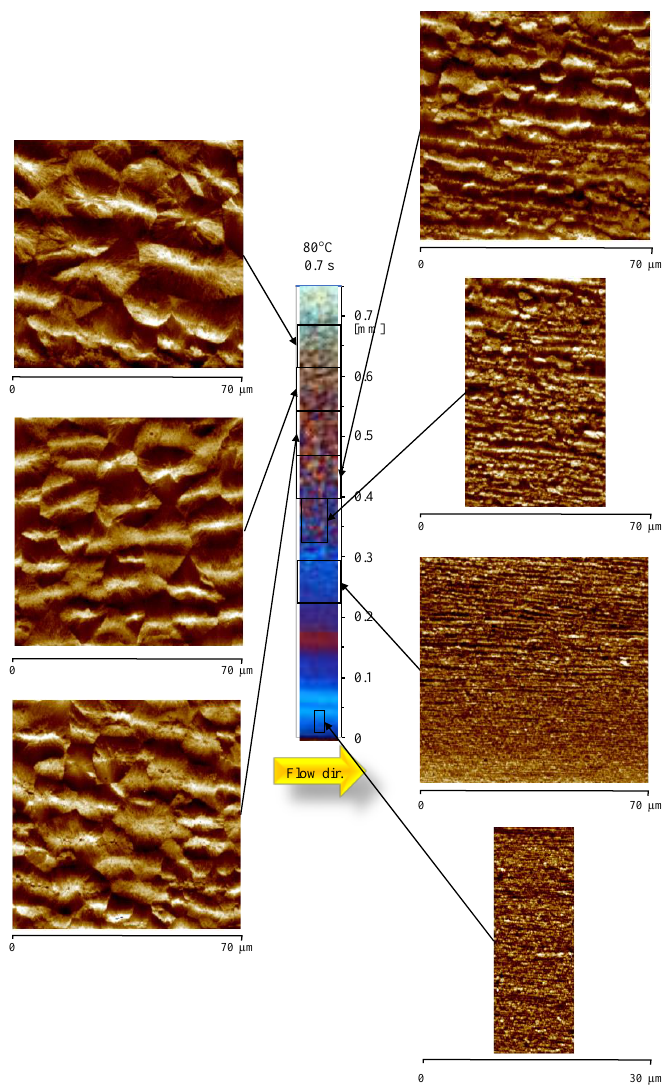
Figure 4. Optical micrograph and AFM height maps, at different distances from the sample surface, of the sample 80-07, at 15 mm downstream the gate.